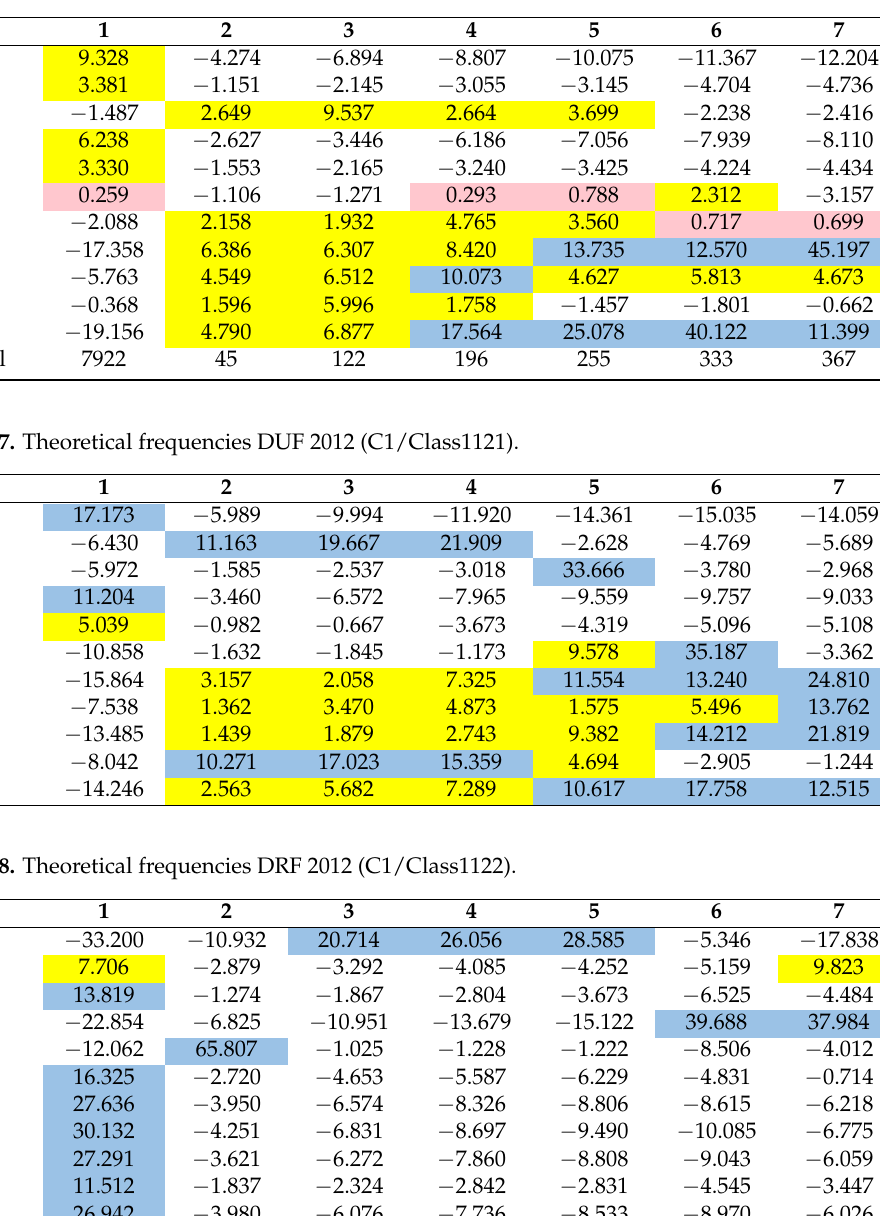
Table A6. Theoretical frequencies CUF 2012 (C1/Class111).